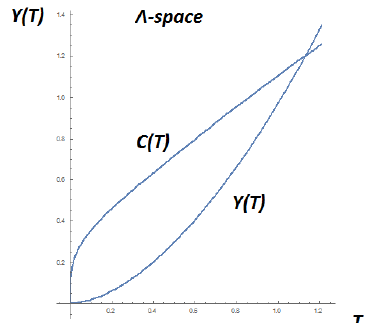
Figure 5. The conjugate curve Y ( T ) with its curve of the centers of curvature in the Λ -space for γ = 0.6.